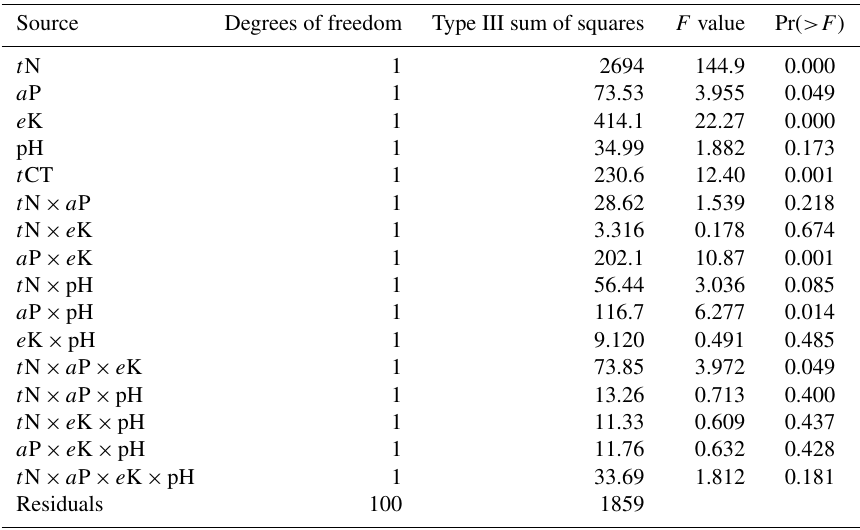
Table 5. Results of full univariate ANOVA model to explain the status of soil organic carbon density at the study site ( R 2 = 0 . 848,